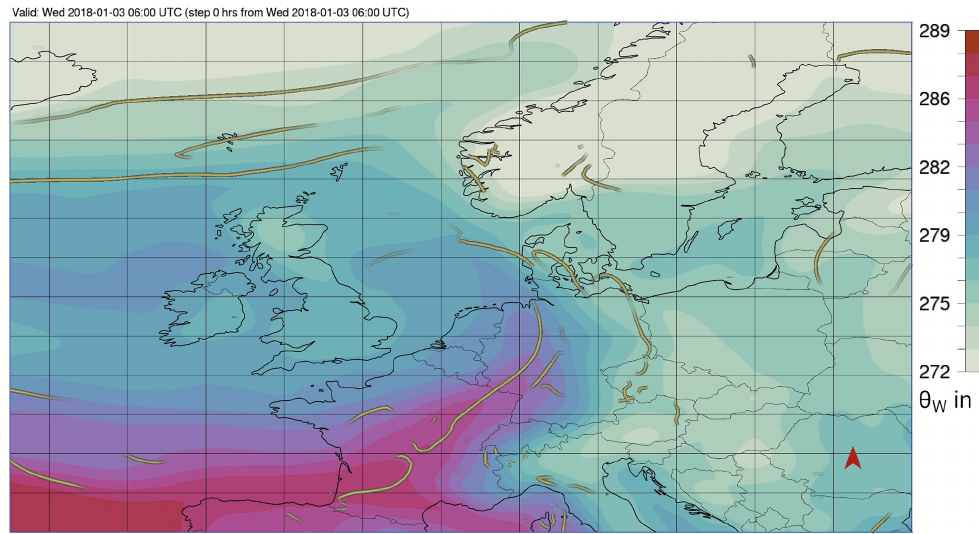
Figure D4. Detected fronts at 850hPa (green tubes) and wet-bulb potential temperature θ W (shading) for storm Burglind on 3 January 2018 at 06:00UTC using the Met.3D visualisation software (Beckert et al., 2022; Rautenhaus et al., 2015). Data source: ERA5.